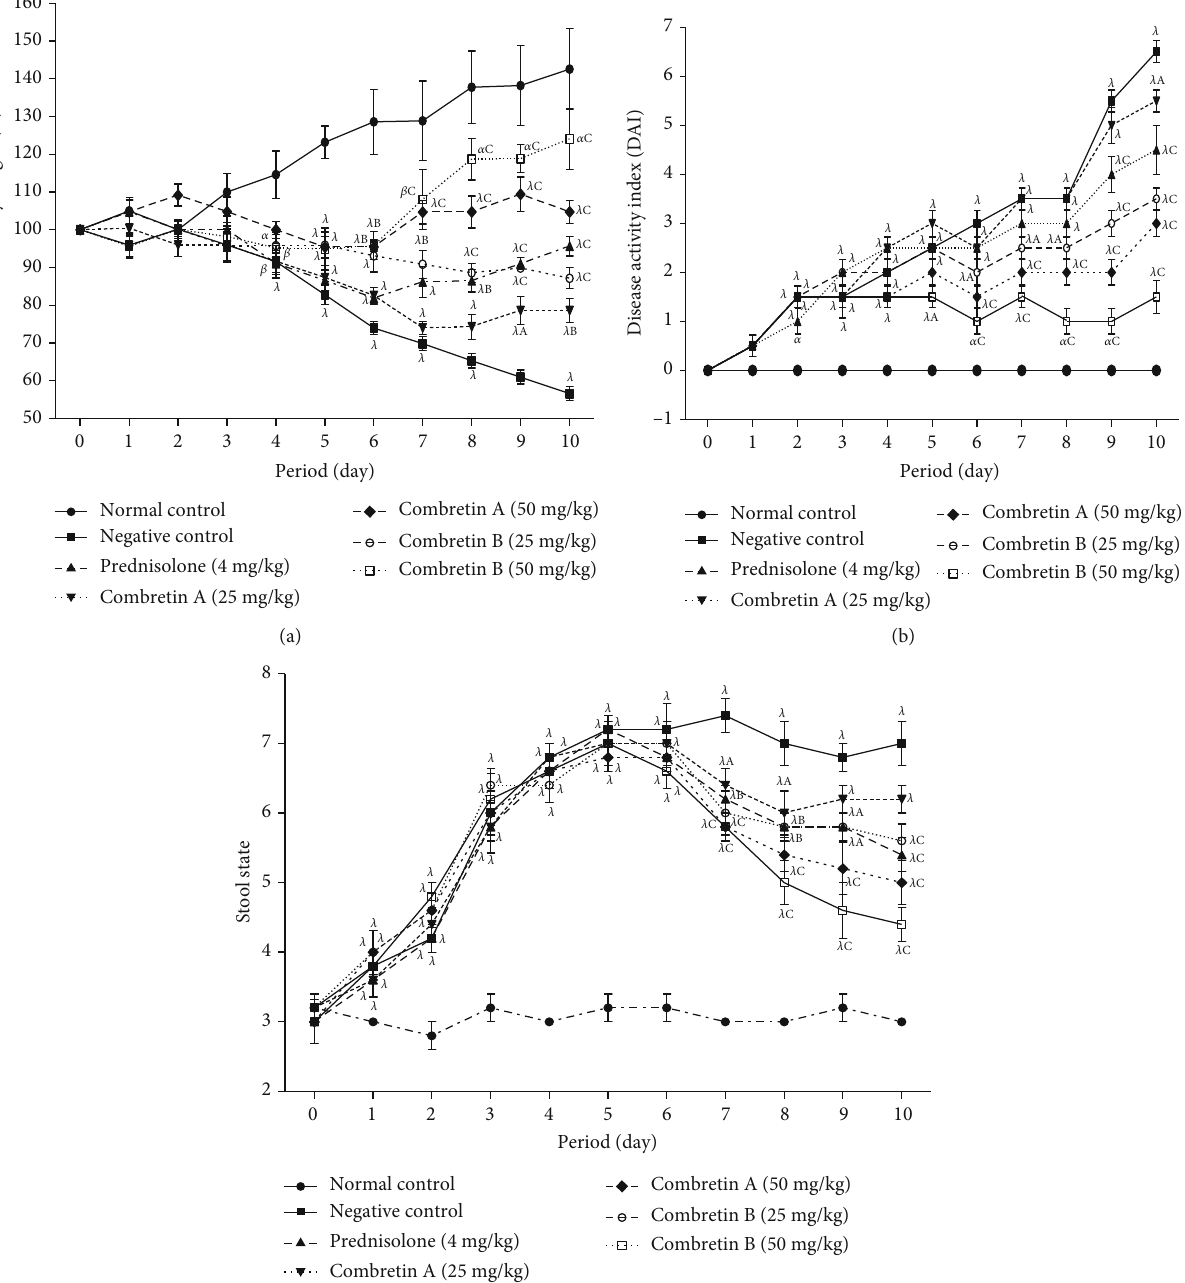
Figure 2: E ff ect of Combretin A and Combretin B on relative body weight (a), disease activity index (DAI) (b), and stool state (c) in DSS- induced colitis in rat. Values are expressed as mean ± SEM for six animals and analyses by two-way ANOVA followed by Bonferroni post hoc test. A p < 0 : 05 , B p < 0 : 01 , C p < 0 : 001 : signi fi cant di ff erence compared with negative control; α p < 0 : 05 , β p < 0 : 01 , λ p < 0 : 001 : signi fi cant di ff erence compared with normal